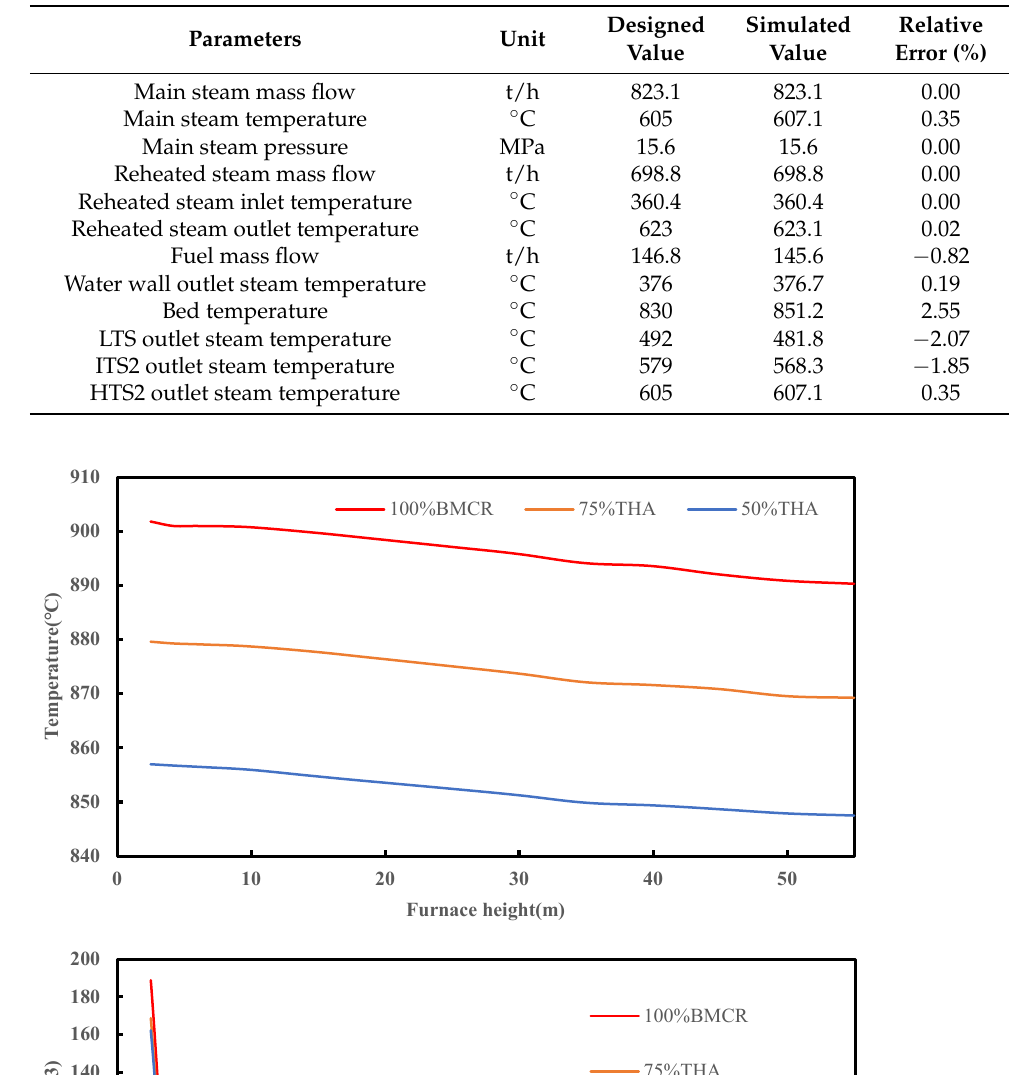
Table 3. Simulation results at 50% THA.